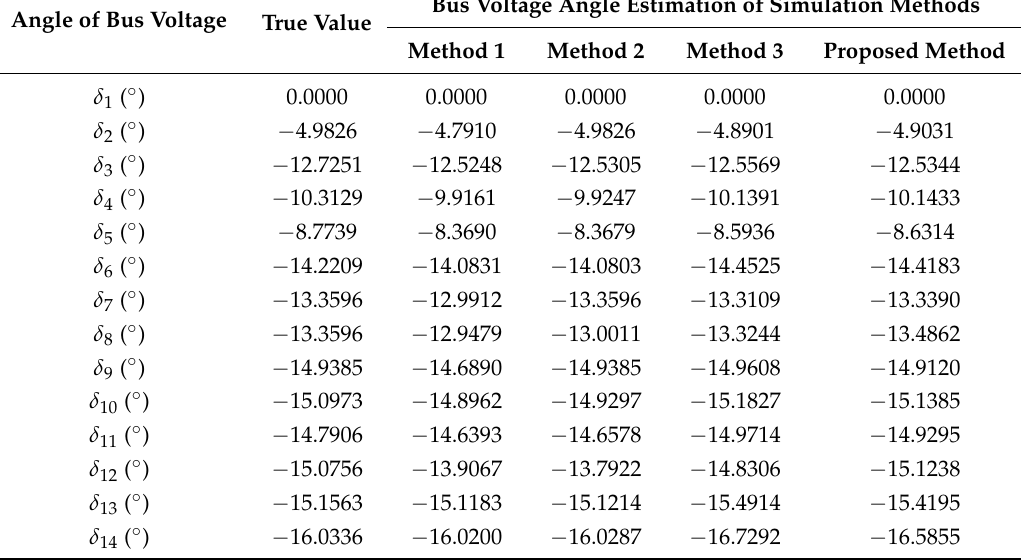
Table 2. Bus voltage angle estimation of four methods used in 14 bus system.